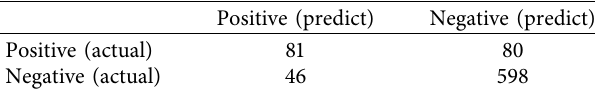
Table 14: Confusion matrix of the low precision data